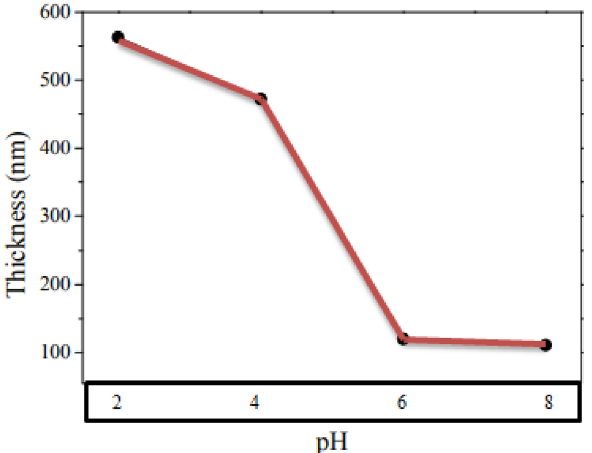
Figure 10. Thicknesses of PbS thin films prepared at changed pH value for a constant deposition time of 2